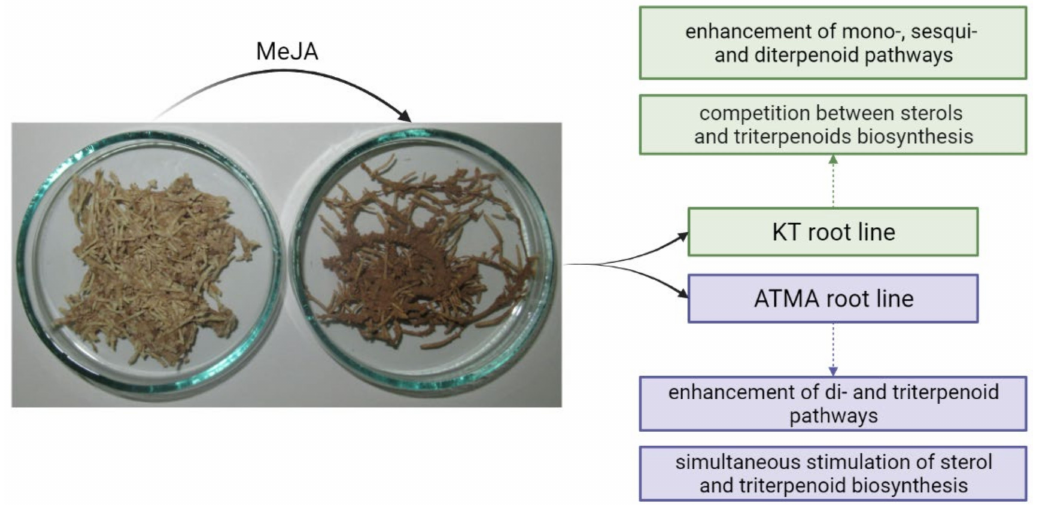
Figure 7. The main metabolic changes occurring in the terpenoid pathway in the KT and ATMA lines of T. × media hairy roots after elicitation with MeJA. The included picture (representative samples of the control and MeJA-treated ATMA root line) shows the visible difference between the control and elicited hairy